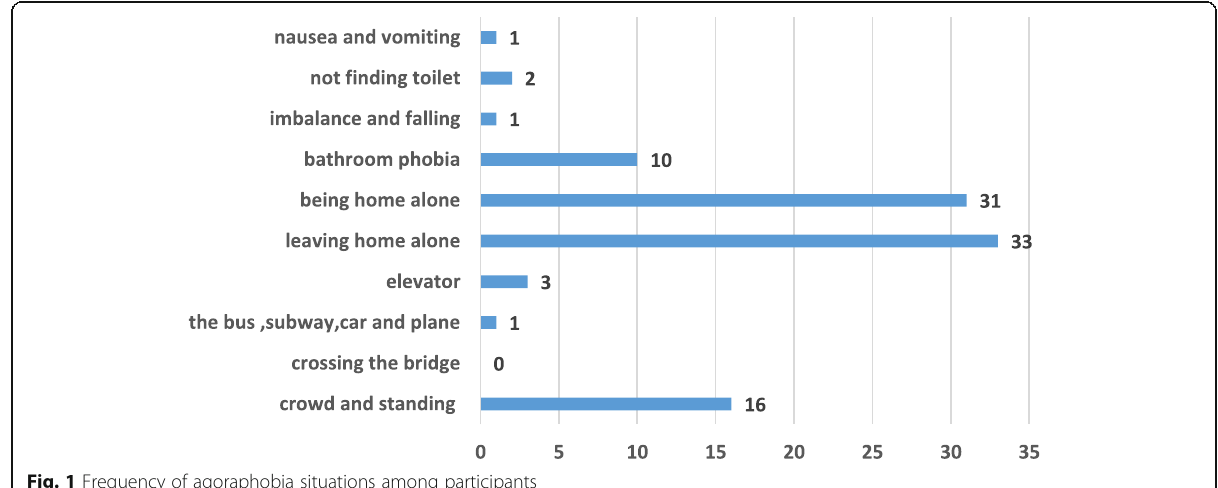
Fig. 1 Frequency of agoraphobia situations among participants